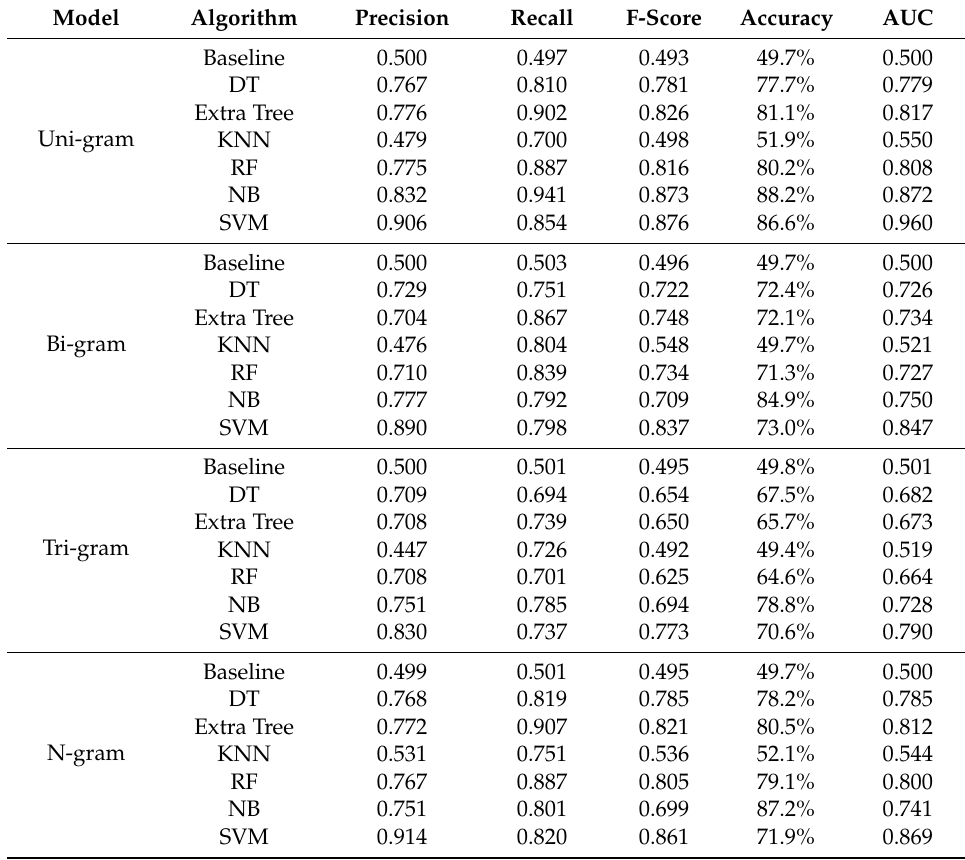
Table 15. Summary for classification algorithms with n-gram model on training dataset.